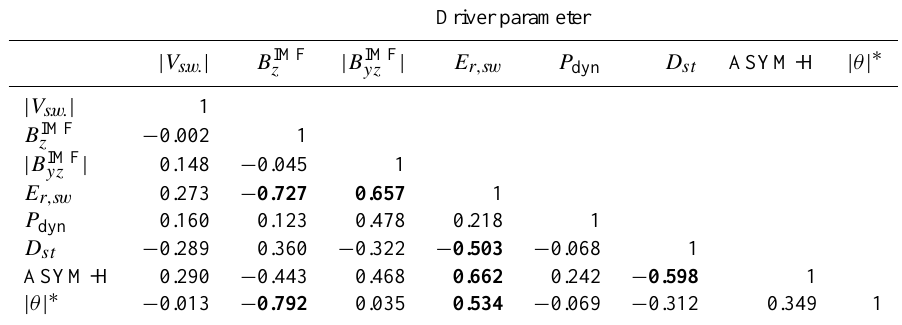
Table 1. Correlations between the various driver parameters (using all bias-filtered data).